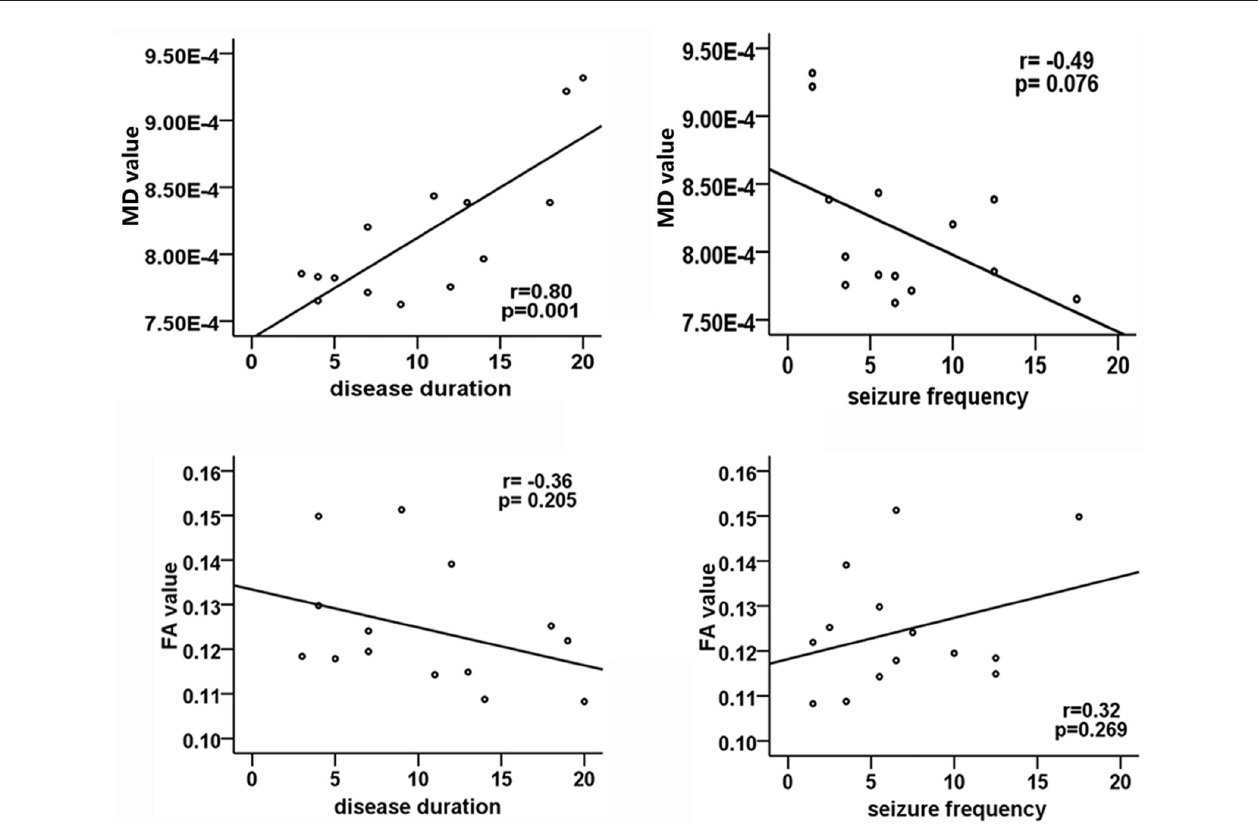
FIGURE 3 | Correlation analysis between DTI metrics and clinical parameters in patients group. The Pearson correlation coefficient and p value are plotted in each case. Significant correlation only exists between MD values and disease